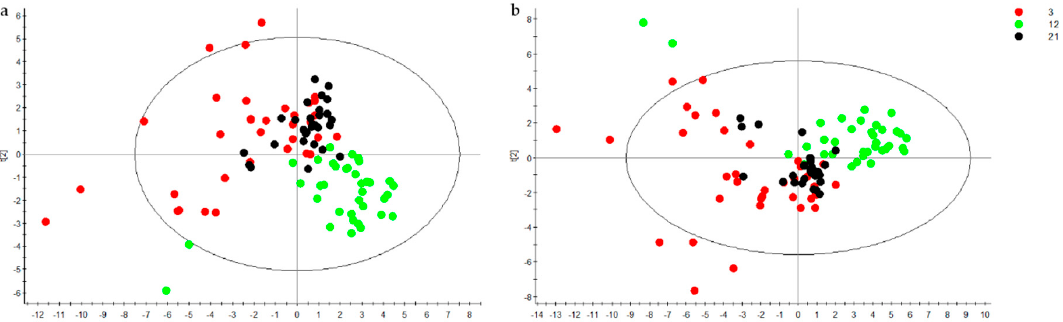
Figure 1. PCA scores plots of urine samples from young (3-month old, red dots), middle-aged (12- month old, green dots) and old rats (21-month old, black dots), normalized by total ion current ( a ) and creatinine ( b ). Ellipse represents 95% confidence intervals of Hotelling’s T 2 distribution.